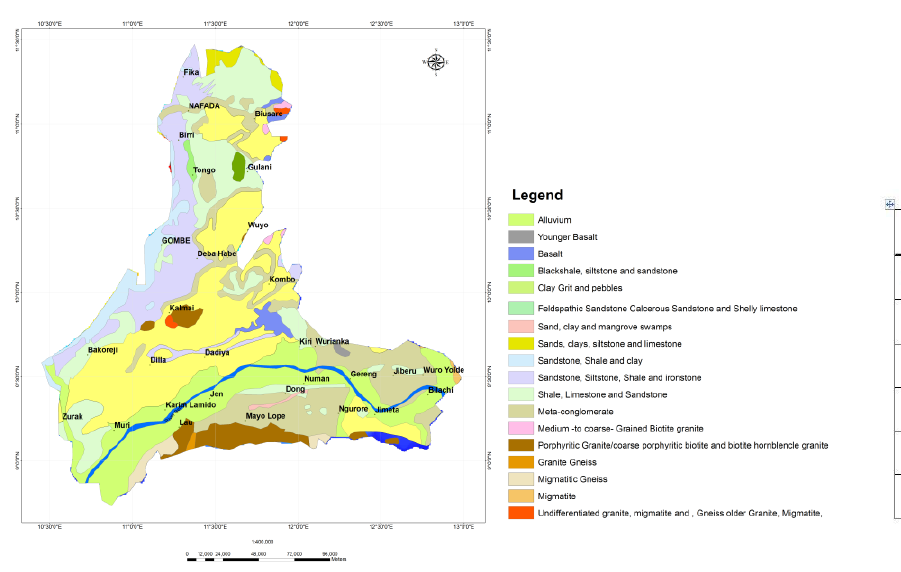
Figure. 3. Stratigraphic correlation of Upper cretaceous strata in Upper Benue trough (Idowu and Ekwezor, 1989).